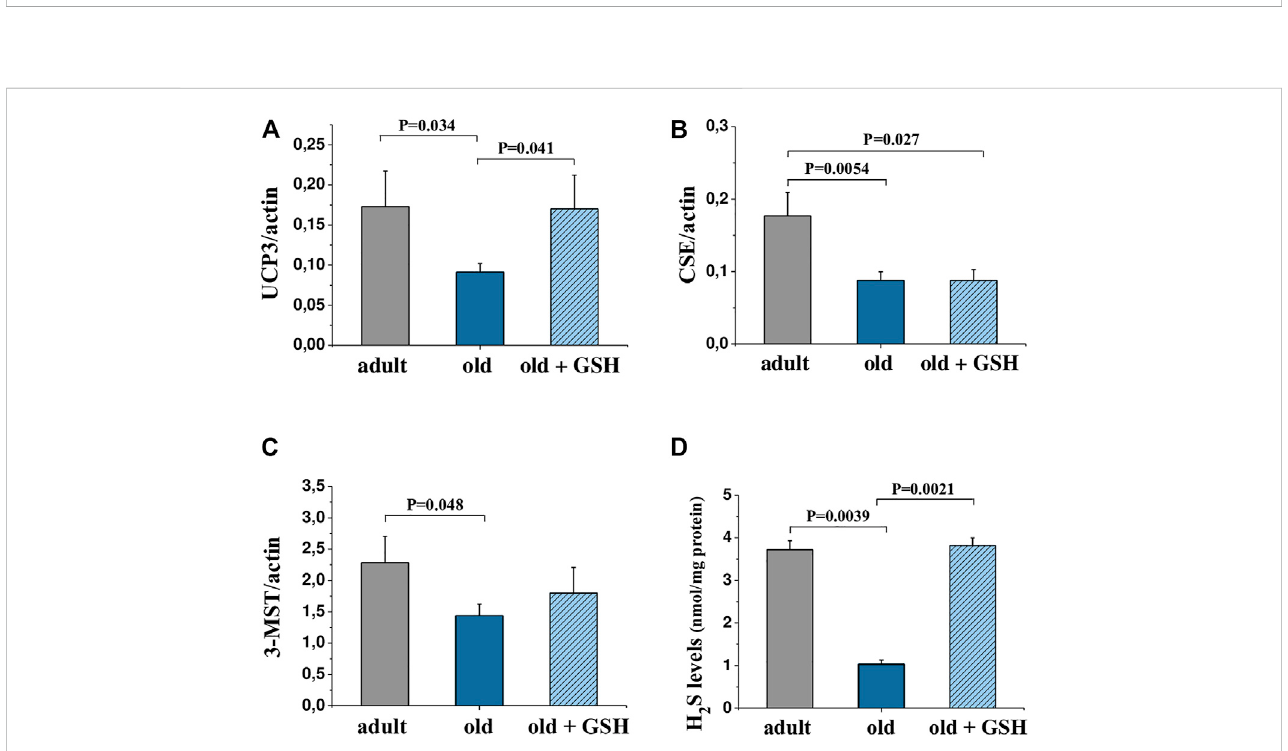
FIGURE 3 mRNAlevelsofgenesencoding UCP3 (A) , CSE (B) and 3-MST (C) inthehearttissueandH 2 Slevelsinheartmitochondria (D) ofadult,oldandglutathione- treated old rats. GSH, glutathione. Data are represented as mean ± SEM; n = 7 – 9. Indicated p values were calculated by Kruskal-Wallis rank sum